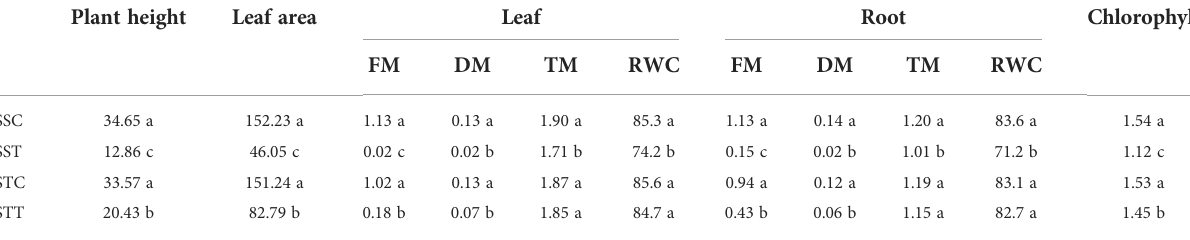
TABLE 1 Plant physiological indicators for plant height, leaf area, leaf (FM, DM, TM, RWC), root (FM, DM, TM, RWC), and chlorophyll of salt- sensitivity (SS). Plant